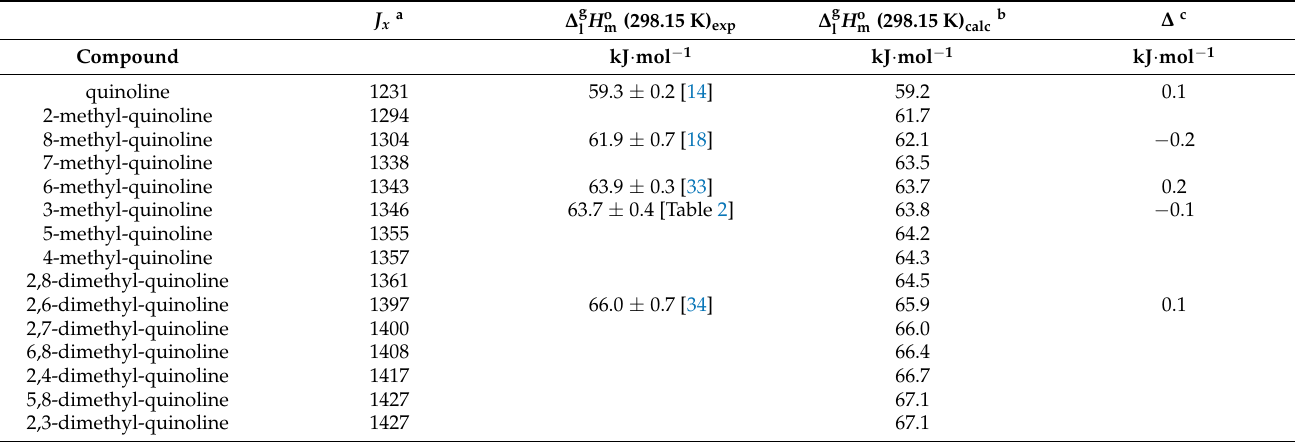
H o m (298.15 K), of quinolines with their Kovats ´ s indices ( J x l